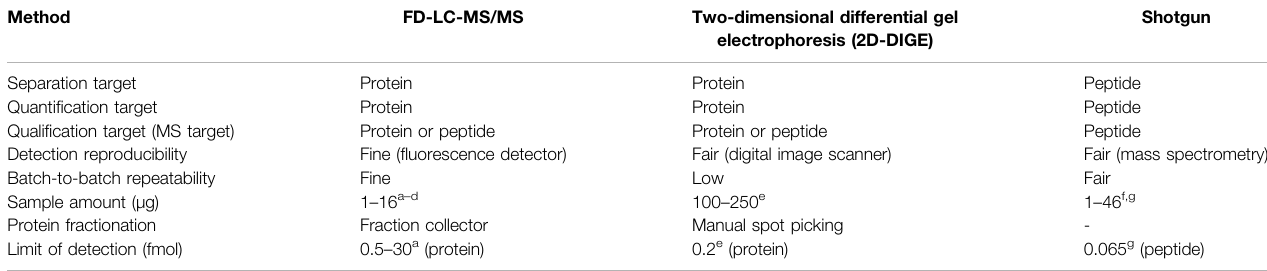
TABLE 1 | Speci fi cations of each proteomics